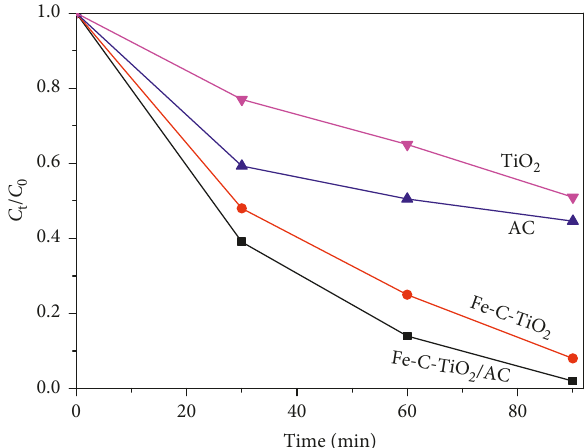
Figure 8: Comparison of photocatalytic activity of Fe-C-TiO